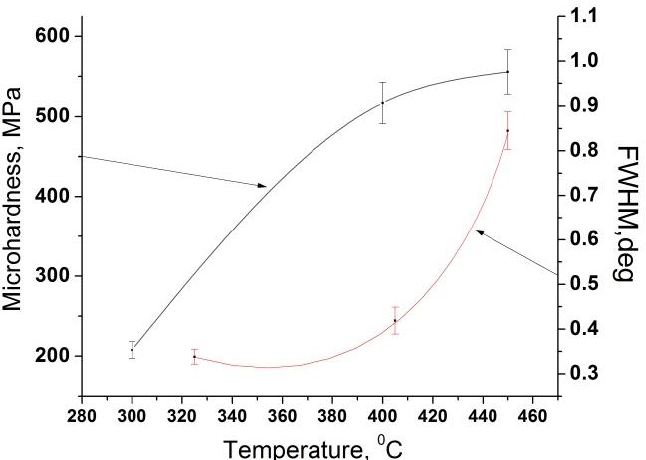
Figure 8. Dependence of microhardness (MPa) and broadening of X-ray spectral lines (110) on Ta condensation temperature.